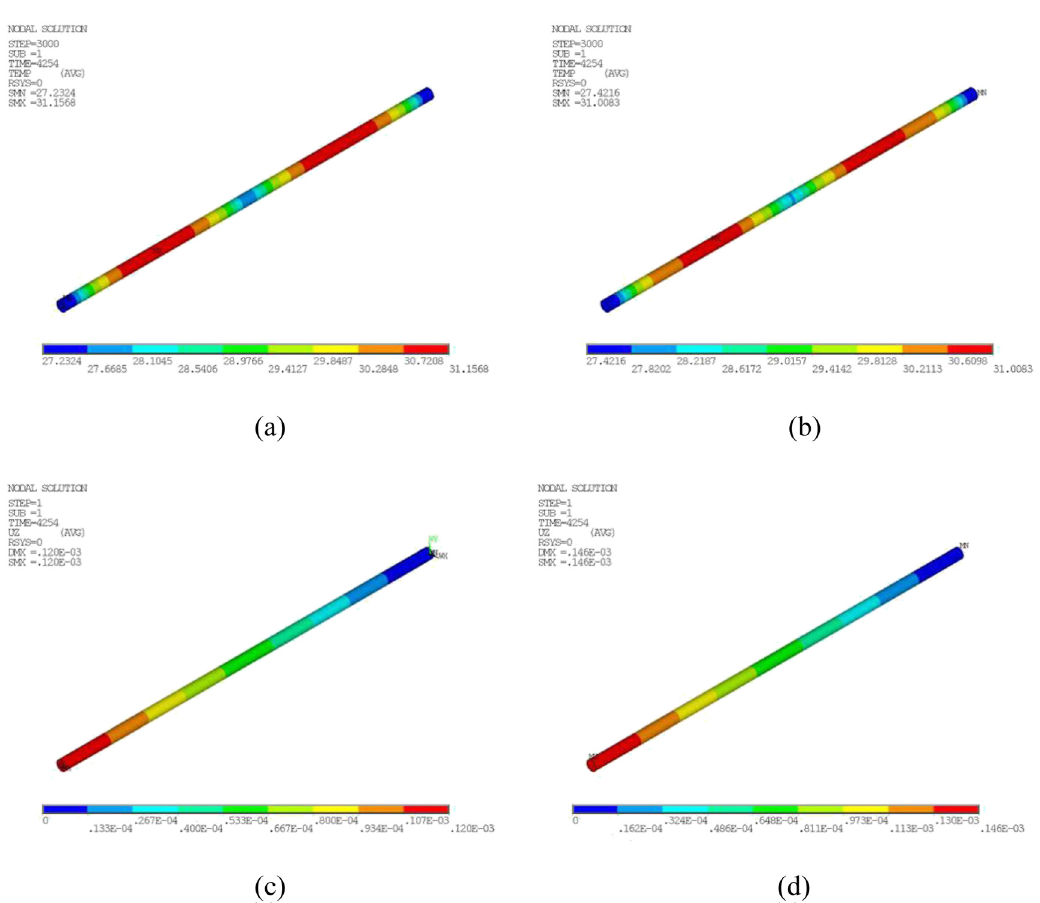
Figure 5: Simulation results of two types of ball screw at 1,100 rpm; temperature distribution of the bio - inspired ( a ) , and standard ball screw ( b ) ; thermal deformation of the bio - inspired ( c ) , and standard ball screw ( d )